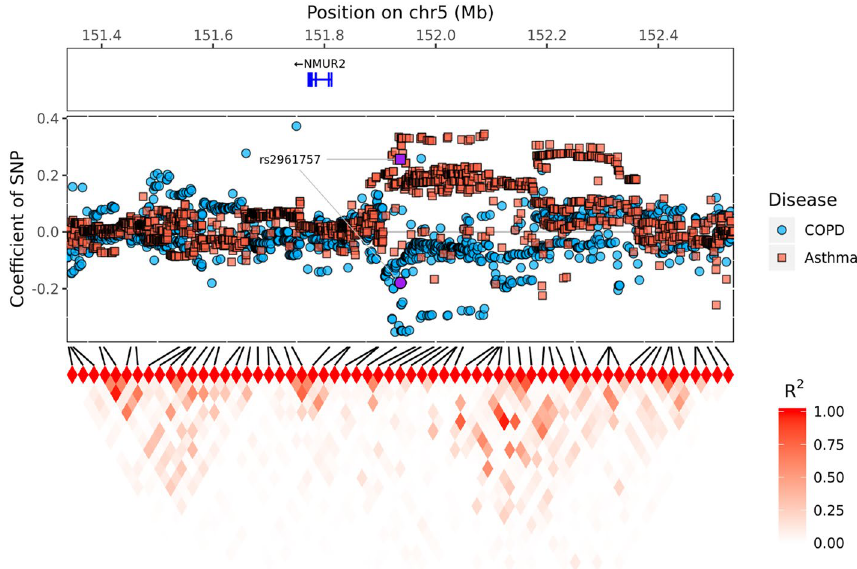
Figure 3. SNP coefficients for Asthma and COPD disease in the target region. The top box shows the located coding gene in the target region. The middle box represents the coefficients of SNPs. The red and blue squares represent the coefficients of SNPs for the asthmatic patients and controls and the COPD patients and controls, respectively. The tile graph at the bottom shows the correlation between the genotyped SNPs, and the amount of correlation is shown by the darkness of the red